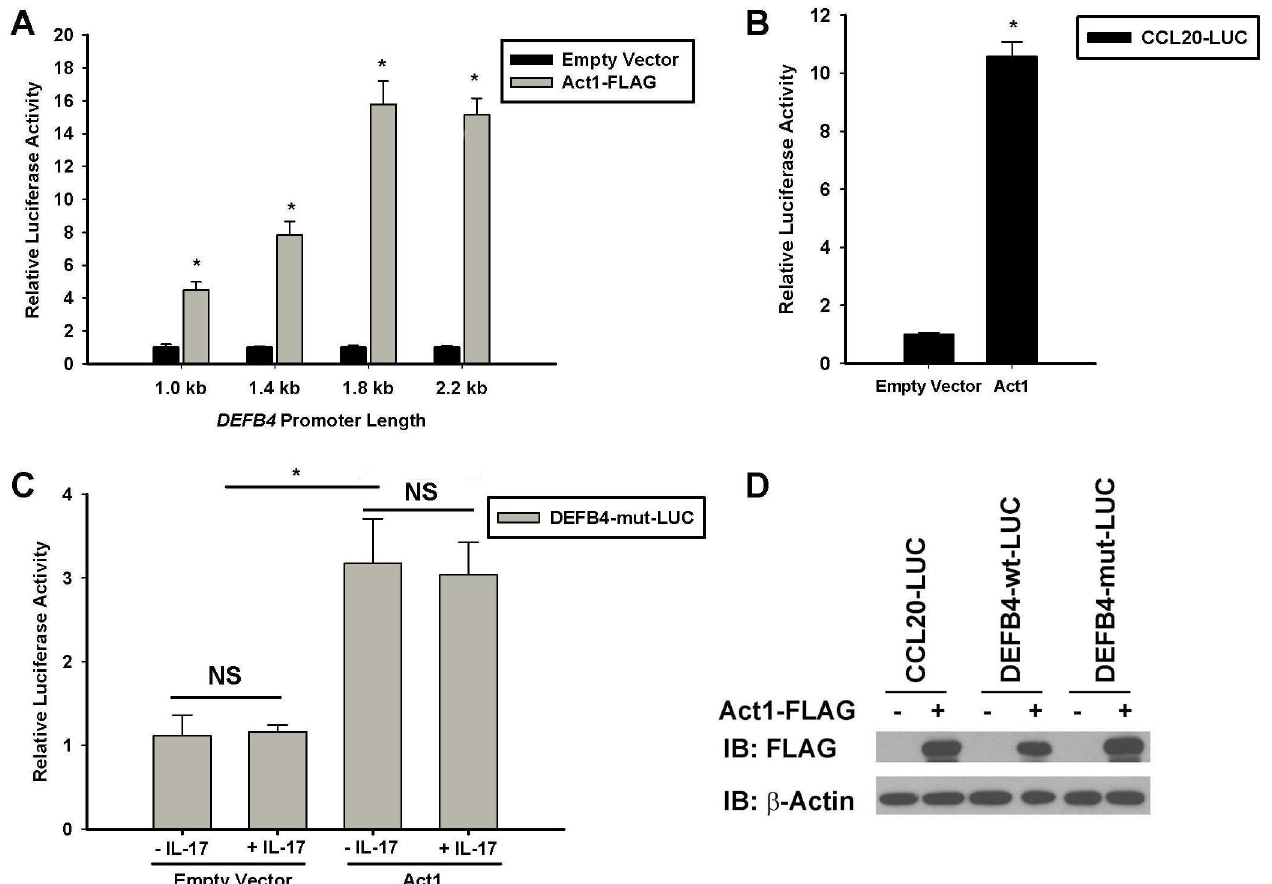
Fig 4. Act1 drives target gene promoter activity. (A) HBE1 cells were transiently co-transfected with DEFB4 promoter-luciferaseconstructs, pRL-TK and either empty vector or Act1-FLAG (n = 6) and lysed 24 hours post-transfection. * p < 0.05 compared to empty vector (EV) transfected cells. (B) HBE1 cells were co-transfected with a CCL20 promoter-luciferase construct (CCL20-LUC), pRL-TK and either empty vector or Act1-FLAG (n = 4) and lysed 24 hours post-transfection. * p < 0.05 comparedto empty vector (EV) transfected cells. (C) HBE1 cells were co- transfected with a DEFB4 promoter-luciferase construct in which all 3 NF- κ B bindingsites are mutated (DEFB4-mut-LUC), pRL-TK and either empty vector or Act1-FLAG. 24 hours post-transfection, cells were left unstimulated (-IL-17A) or stimulated with 100 ng/mL IL-17A for 6 hours (n = 4). Lysate was measured for firefly and Renilla luciferaseactivity. Firefly luciferaseactivity was normalized to Renilla luciferase activity and calibratedto empty vector transfected controls. * p < 0.05 compared to empty vector (EV) transfected cells. NS: not significant when IL-17A